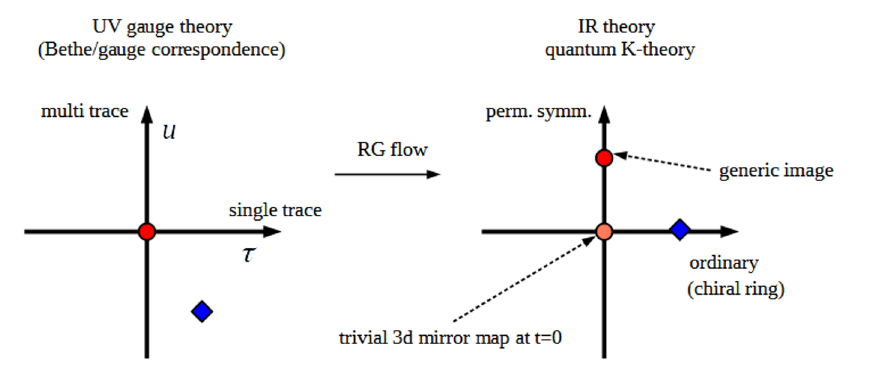
Figure 1 . The figure illustrates the RG flow — as encoded in the 3d mirror map — between the UV gauge theory with perturbations by multi- and single-trace operators and the IR quantum K-theory description with the ordinary and permutation symmetric deformations. A generic UV gauge theory without multi- and single-trace perturbations yields a permutation symmetric deformation in quantum K-theory (pair of red dots), whereas an ordinary deformation in quantum K-theory arises generically from a UV theory with both single- and multi-trace perturbations (pair of blue diamonds). For theories with a trivial 3d mirror map, the unperturbed UV gauge theory (red dot on the left) flows to a quantum K-theory without deformations (orange dot on the right). For such theories, single-trace perturbations in the UV gauge theory are sufficient to yield the ordinary quantum K-theory